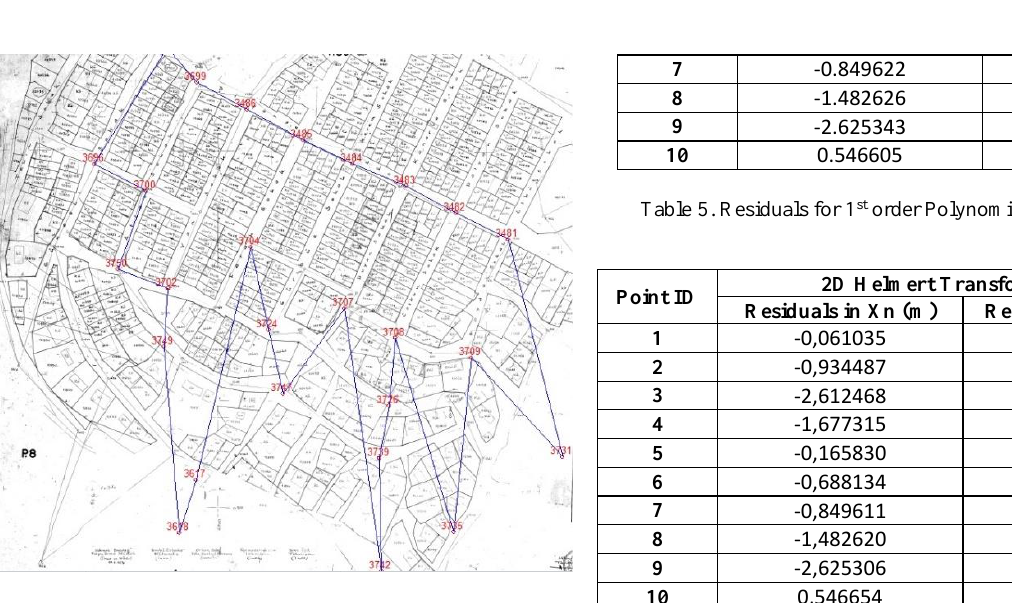
Figure 3. Cadastral map test point representation